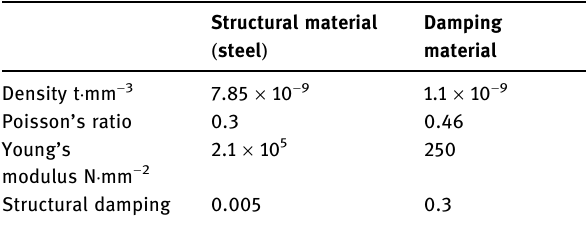
Structural material ( steel )